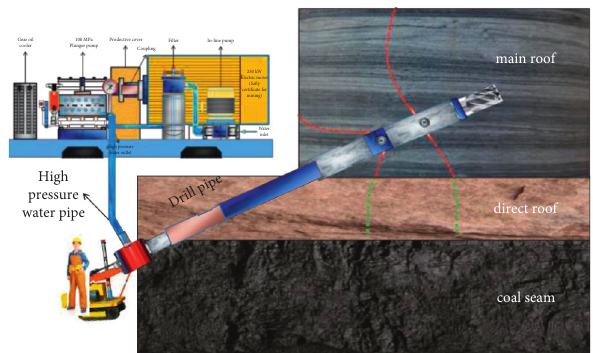
Figure 10: Schematic diagram of water jet cutting top plate process.